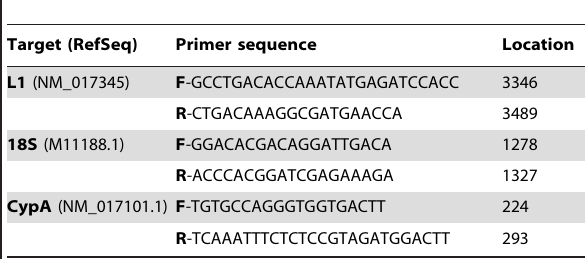
Table 2. Primers used for PCR amplification of target